Question: Reading the figure, is the described quantity rising or falling?
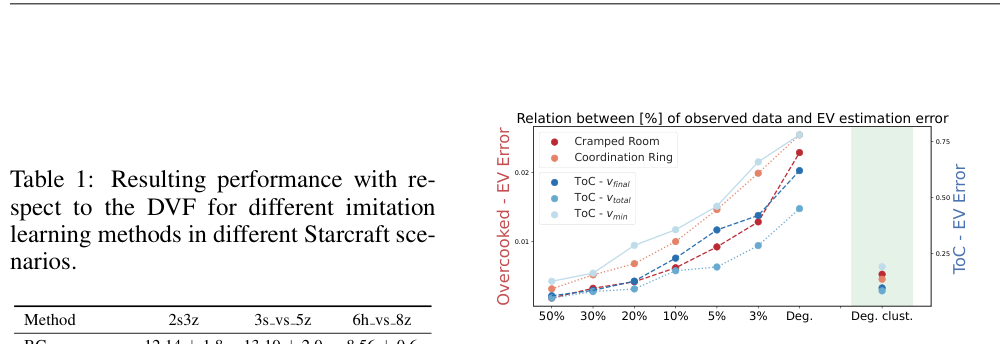
Answer: decreasing